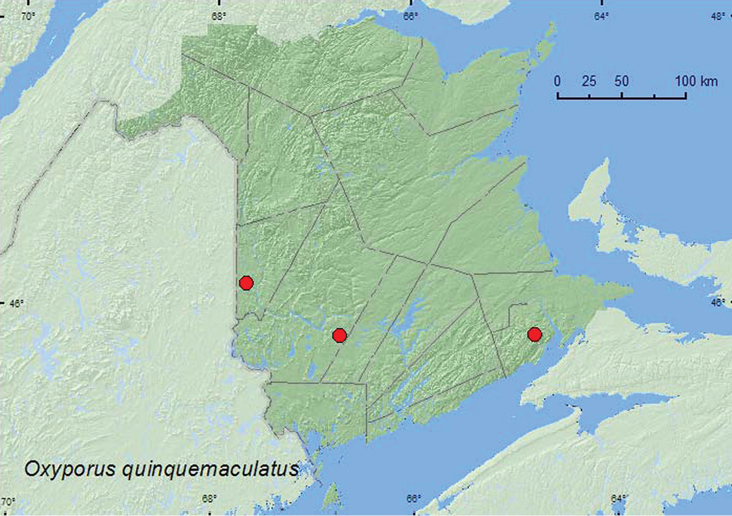
Collection localities in New Brunswick, Canada of Oxyporus quinquemaculatus.